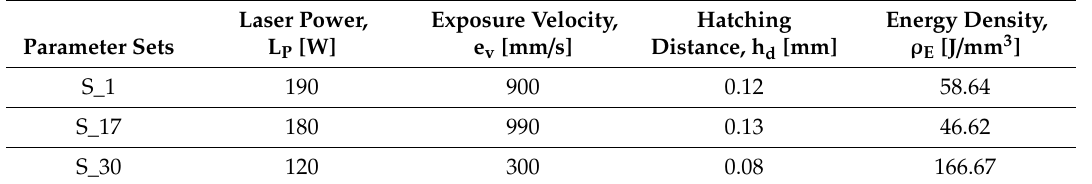
Table 2. Specifications of selected groups of technological process parameters. Parameter